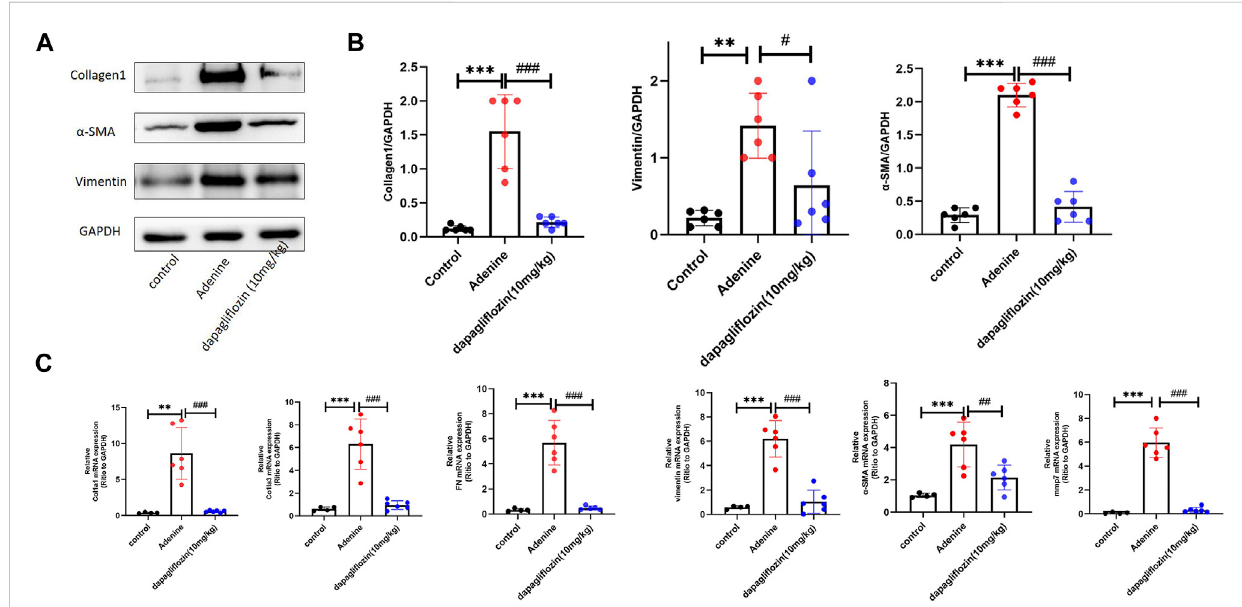
FIGURE 2 Dapagli fl ozin reduced the expression of renal fi brosis-related markers in 0.2% adenine diet-fed mice. (A, B) Western blot showing the expression of Collagen 1, α -SMA, and vimentin in the renal tissue of each group. (C) Real time PCR showing the expression of col1a1, col3a1, FN, Vimentin, α -SMA, and MMP7intherenaltissueofeachgroup.Valuesaremeans±SD.** p < 0.01adeninedietgroupcomparedwiththecontrolgroup;*** p < 0.001adeninediet group compared with the control group; # p < 0.01 dapagli fl ozin treatment group compared with the adenine diet group; ## p < 0.01 dapagli fl ozin treatment group compared with the adenine diet group; ### p < 0.001 dapagli fl ozin treatment group compared with the adenine diet